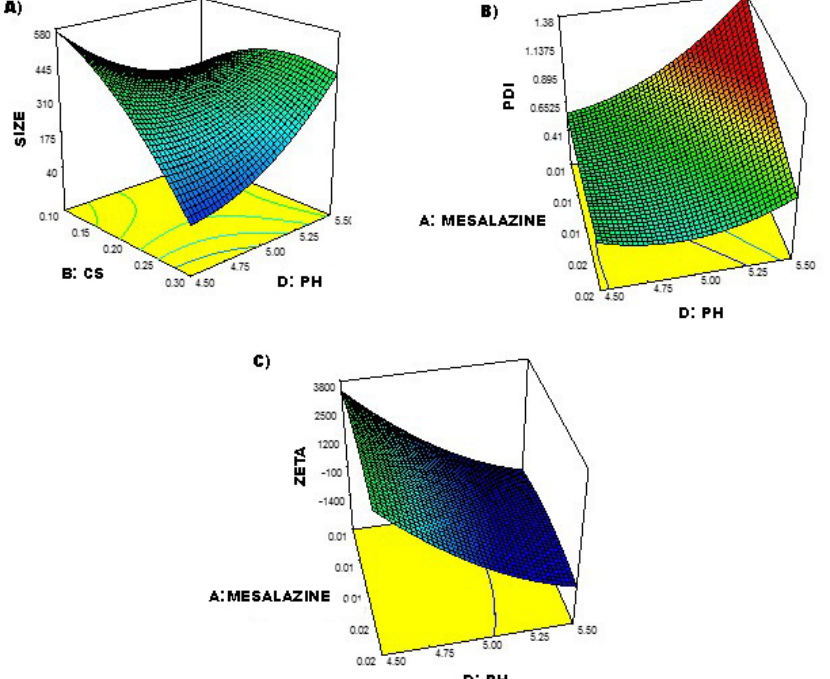
Fig. 2. Response surface plots showing effect of factorial variables on (A) particle size, (B) poly dispersity index and (C) zeta potential